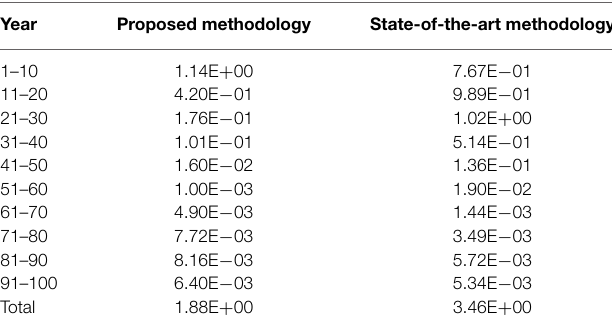
TABLE 5 | Sum of the differences between the condition values predicted using the Markov models and those predicted using the mechanistic-empirical